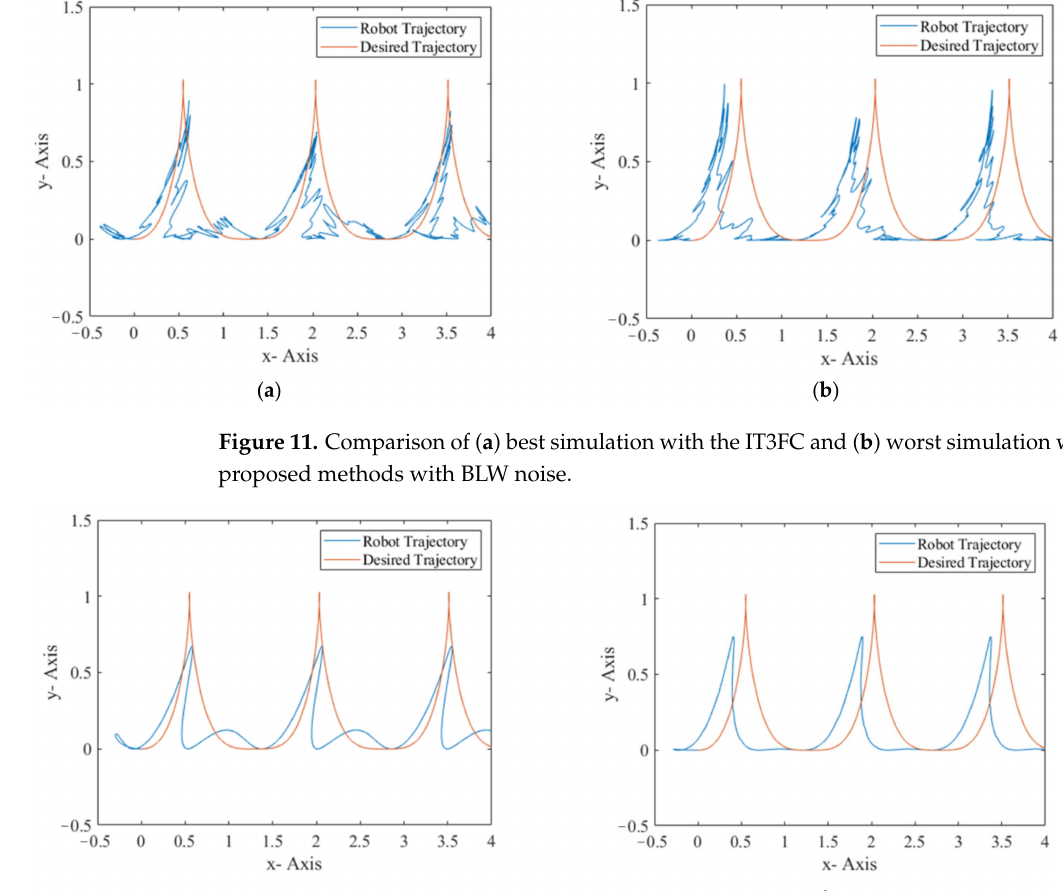
Figure 10. Comparison of ( a ) best simulation with the IT3FC and ( b ) worst simulation with the IT3FC proposed methods without noise.